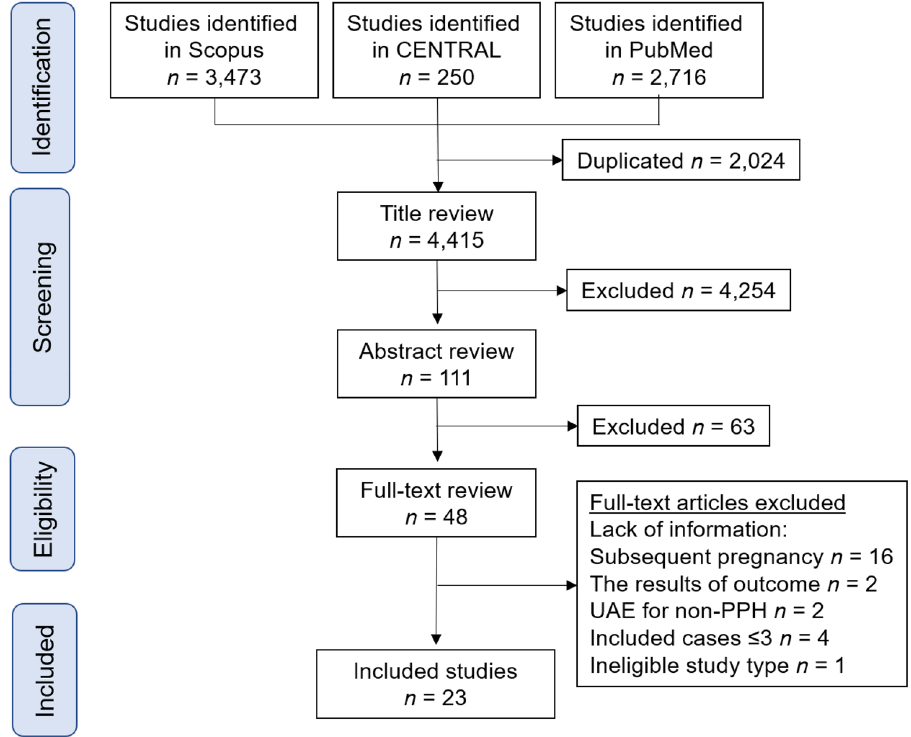
Figure 1. Study selection scheme used for the systematic review of the literature. PPH postpartum hemorrhage, UAE uterine artery embolization, CENTRAL Cochrane Central Register of Controlled